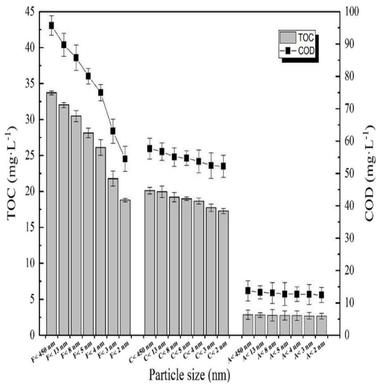
The particle size distribution of COD and TOC during the stepwise process (F-filtration process, C-coagulation process, A-adsorption process).